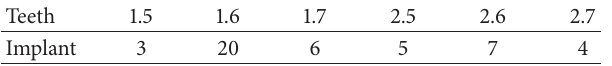
Table 1: Implant positions ( 𝑛 = 45